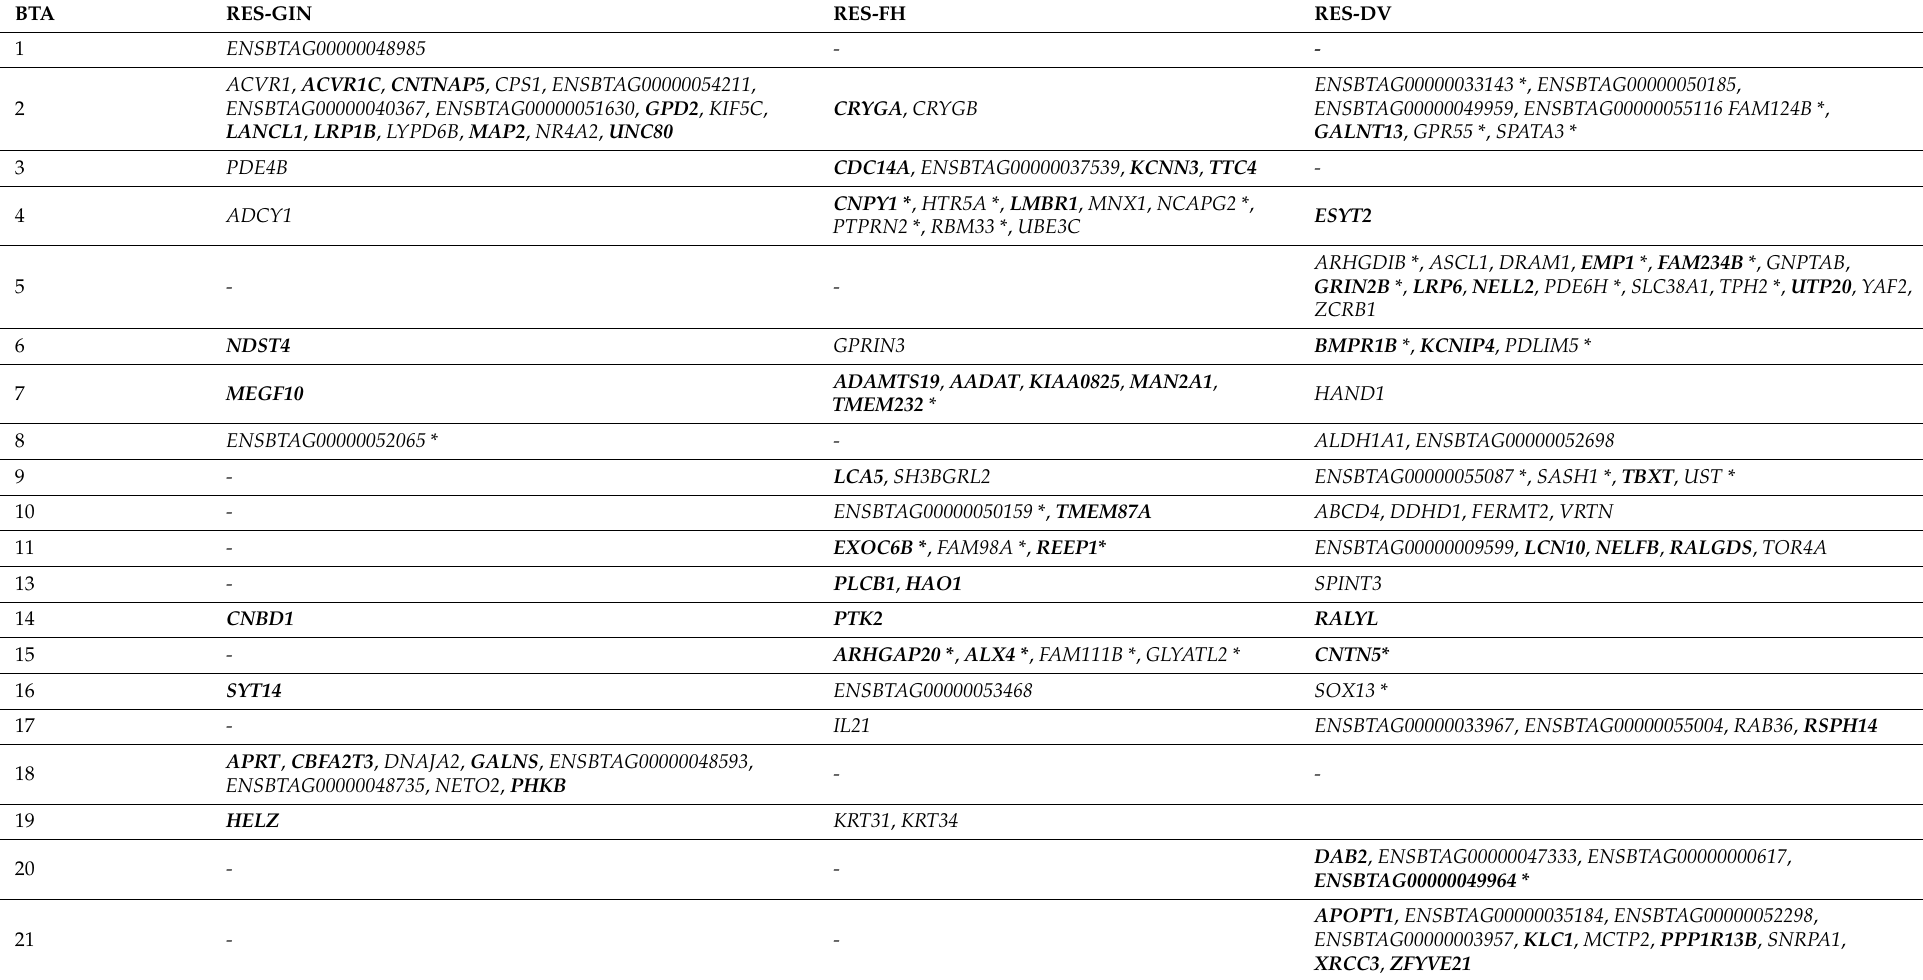
Table 5. Potential candidate genes (sorted alphabetically) related to the identified sequence variants (SVs) associated with residuals for fecal egg counts of gastrointestinal nematodes (RES-GIN), residuals for fecal egg counts of liver flukes (RES-FH), and residuals for fecal larvae counts of bovine lungworms (RES-DV) in DSN. Genes with at least one associated variant in the respective gene are marked in bold. A gene was considered a candidate gene if at least one SV above p Sug was positioned in the respective gene and/or within 100 kb up- and downstream of the